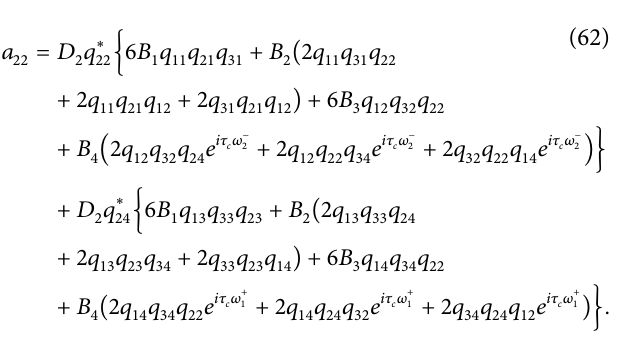
, 𝜀 ) = (0.4, −0.08) , showing a stable periodic 1 2